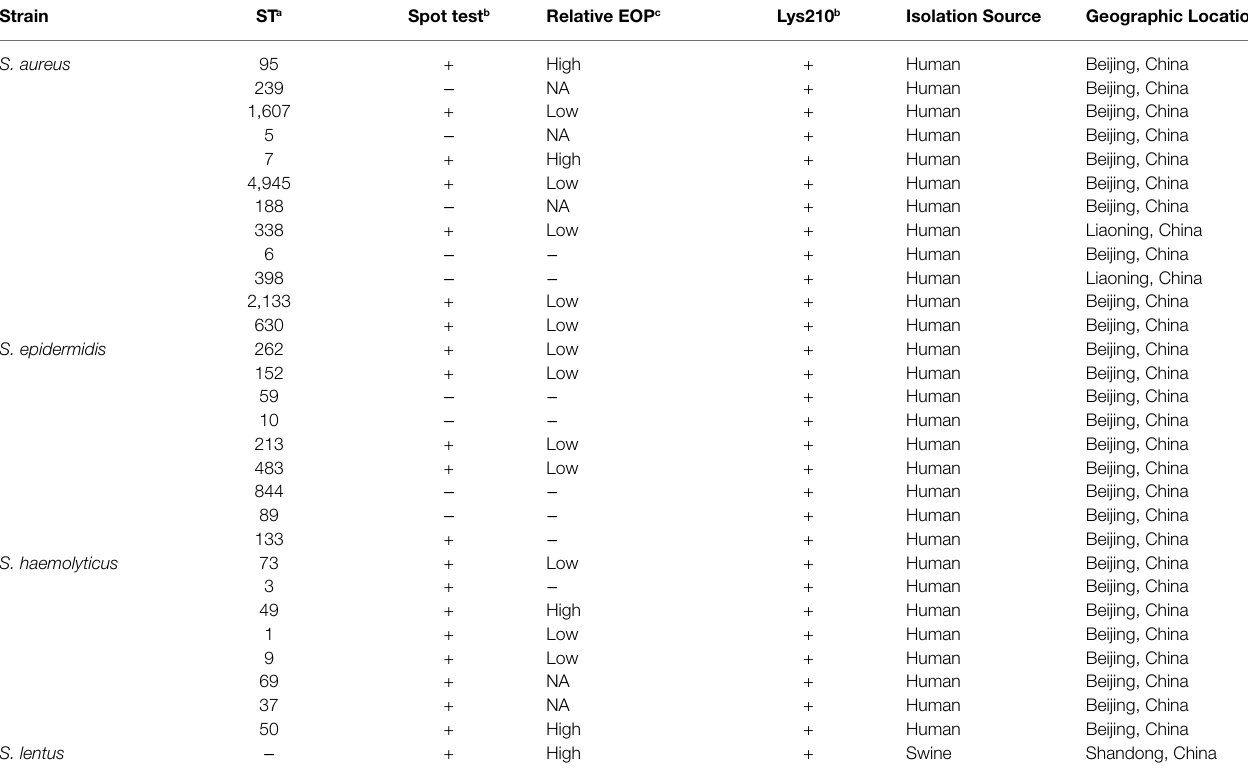
TABLE 1 | Lytic activity of phage SA1 and lys210 against various strains of Staphylococcus . Strain ST a Spot test